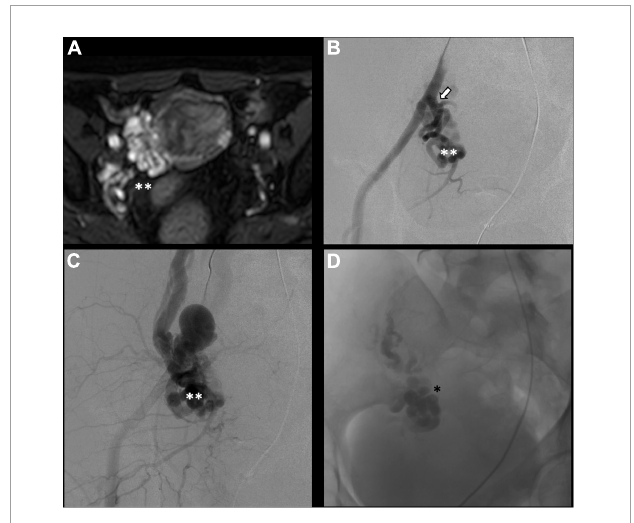
FIGURE4 Type IV pelvic varices in a 44 yo female due to arteriovenous fistula. (A) Magnetic resonance imaging (MRI) shows right-sided pelvic varices (double white asterisks) with flow voids and early opacification in arterial phase. (B–D) Conventional phlebography shows early arterial opacification of varices (double white asterix) due to a fistula from the left internal iliac artery (white arrow), treated with Onyx embolization (single black asterisk).